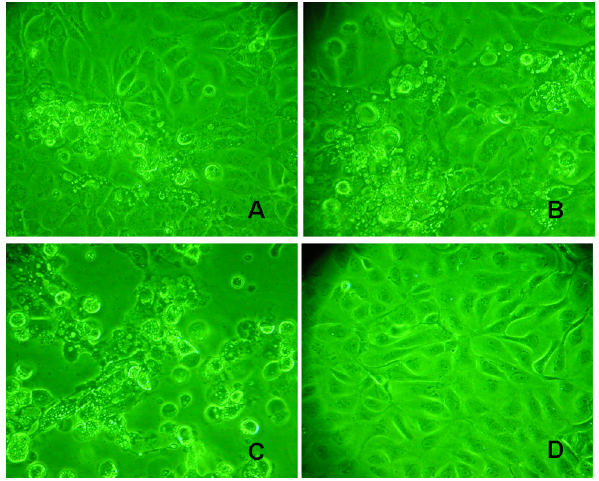
Figure 2. CHSE-214 cell line infected with P.salmonis grown in cell free media (BM1). The typical CFP produced by P. salmonis could be observed in all the times post-infection showing evident cell destruction after 6 days. A: 4 days post-infection; B: 6 days post- infection; C: 8 days post-infection; D: non infected cells (Control).